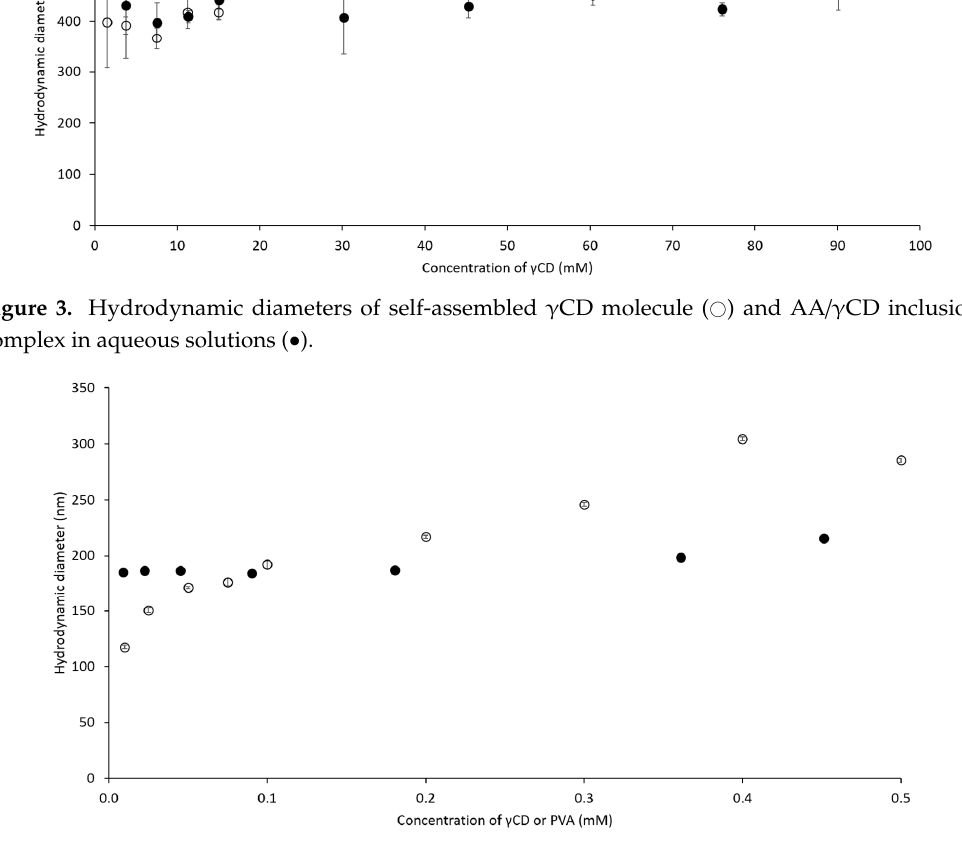
Figure 4. Hydrodynamic diameters of γ CD / PVA inclusion complexes at various concentrations of γ